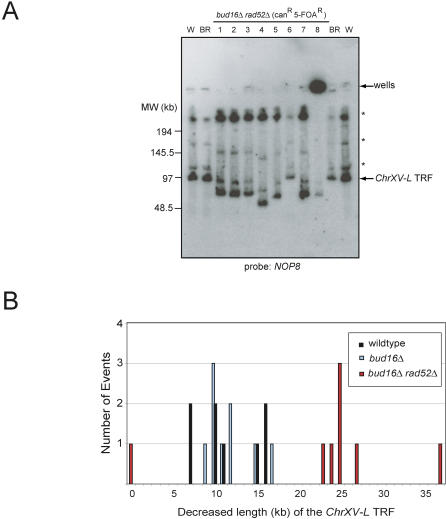
Homologous Recombination Is Required for the BIR-Mediated GCR Events in bud16Δ Cells(A) PFGE analysis of ChrXV-L terminal restriction fragments following PmeI digestion of genomic DNA isolated from either the wild-type (W), parent bud16Δrad52Δ strains (BR), or bud16Δrad52Δ strains that have undergone a GCR event (1–8). Asterisk indicates incomplete digestion products of ChrXV. An undigested Chromosome XV likely explains the presence of a signal in the well of strain 8, although a weak TRF signal can be detected.(B) Quantitation of the terminal restriction fragment length decrease following GCRs when the PmeI TRFs from bud16Δ and bud16Δrad52Δ cells are compared to those of wild type.TRF, terminal restriction fragment.